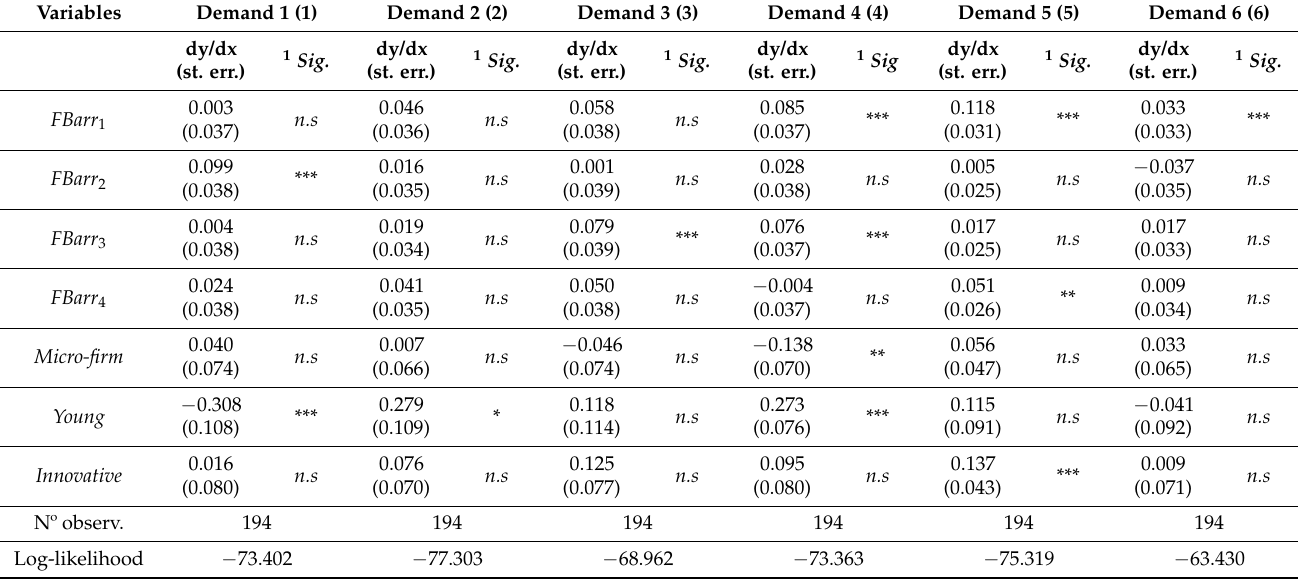
Table 10. Demand for government